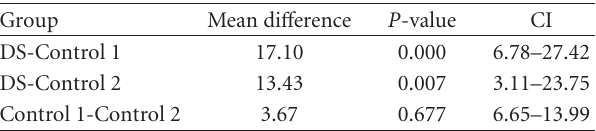
Table 3: ICON one way ANOVA with pairwise Sche ff ´e comparisons between groups.